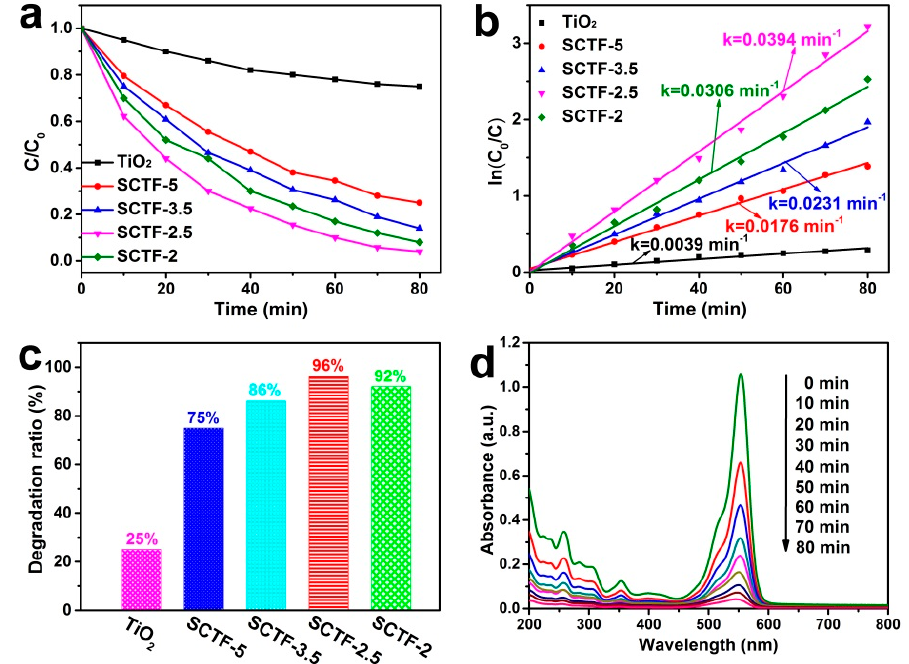
Figure 4. Photocatalytic degradation curves ( a ), kinetic curves ( b ) and degradation ratios ( c ) of RhB for different photocatalysts under simulated solar irradiation. ( d ) Absorption spectra of RhB with SCTF-2.5 as photocatalyst in different reaction times under simulated solar irradiation.